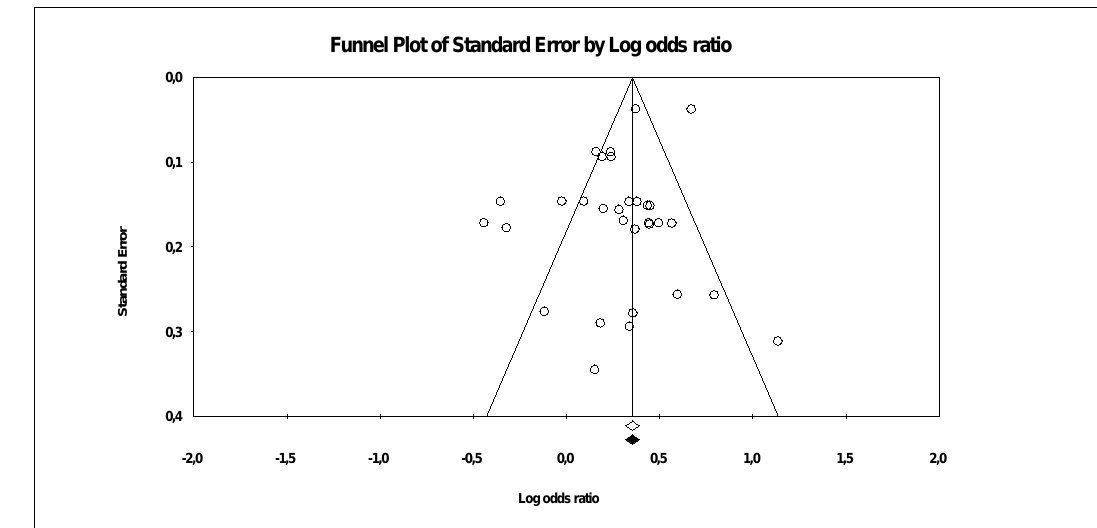
Figure 11. Funnel plots of observational studies of the association of PFOS exposure with CVDs and their risk factors . The publication bias is adjusted by imputing the m issing studies based on the asymmetry of the funnel plot. (●) Plot Imputed and ( ○ ) Plot observed studies. Egger’s linear regression test (Intercept 1.33, t = 2.3, p = 0.04). Adjusted values ‘Trim and Fill’ test (1.30, CI = 1.12, 1.50).